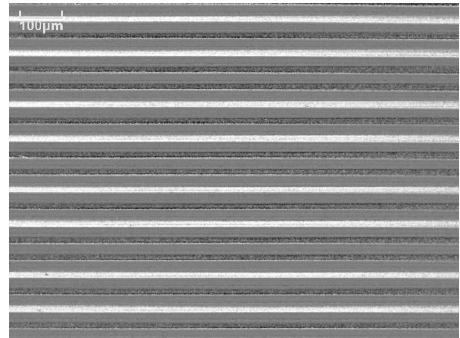
Figure 15. Magnetic domain without applying distributed field ( θ = 71 ° ).